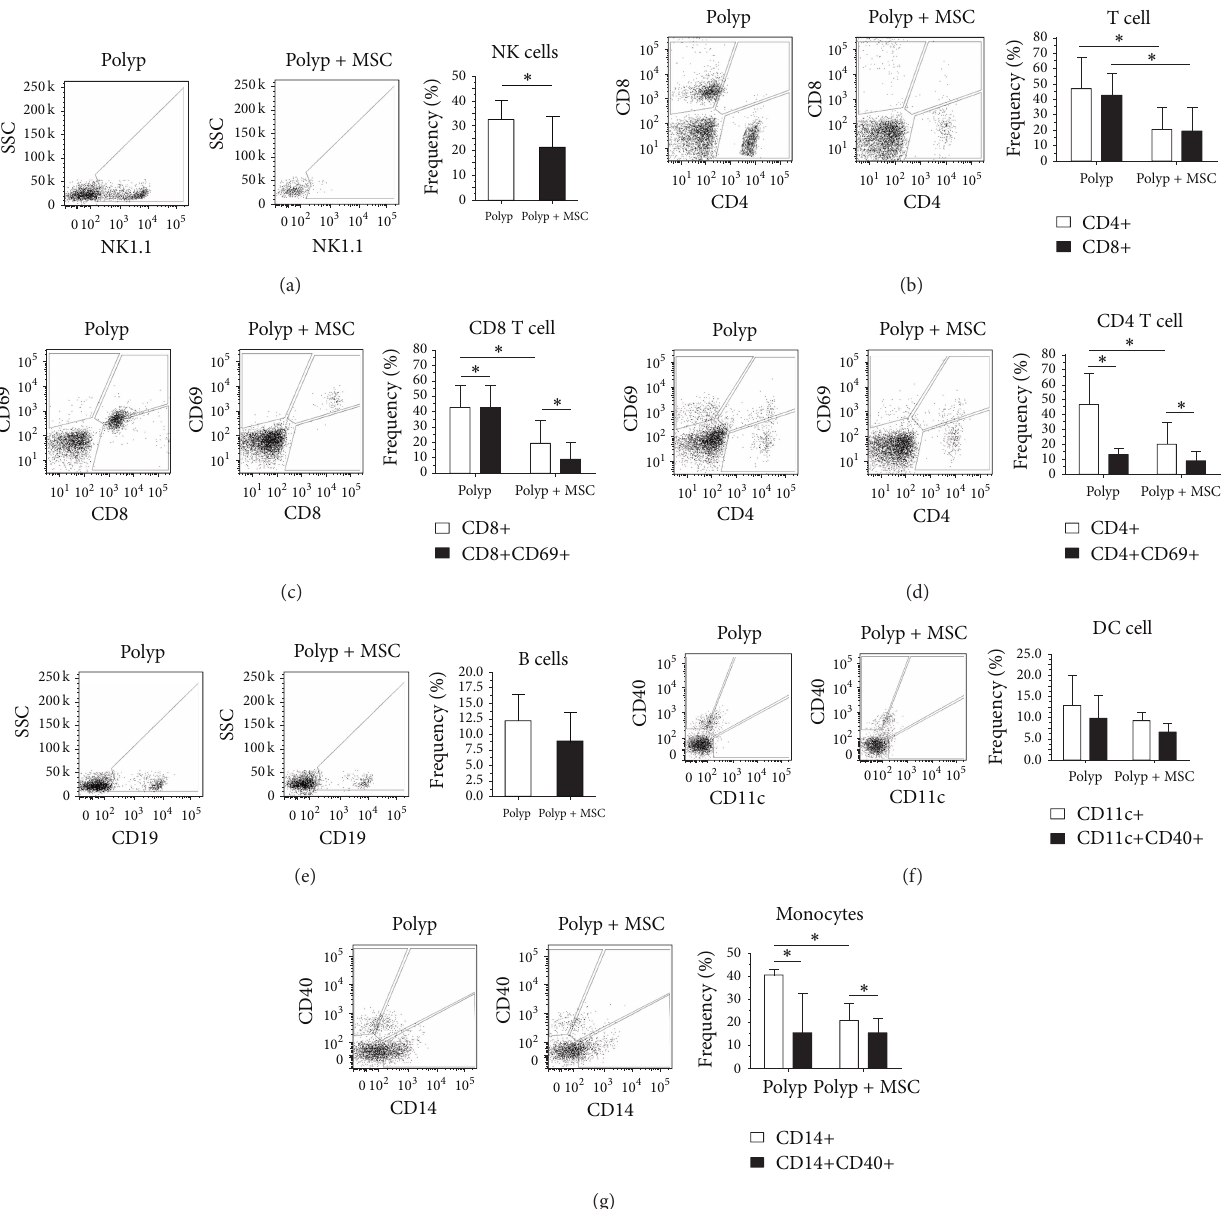
Figure 3: Bone marrow-derived mesenchymal stem cells modulating the polyp microenvironment in vitro . (a) NK cell (NK1.1+) frequency alone and in coculture with MSCs; (b) CD4+ and CD8+ frequencies alone and in coculture with MSCs; (c) CD8+ and CD69+ frequencies alone and in coculture with MSCs; (d) CD4+ and CD69+ frequencies alone and in coculture with MSCs; (e) B cell (CD19+) frequency alone and in coculture with MSCs; (f) CD11c+ and CD11c+CD40+ dendritic cell frequencies alone and in coculture with MSCs and CD14+ and CD14+CD40+ monocyte frequencies alone and in coculture with MSCs. The presence of MSCs may immunomodulate the phenotype of polyp-derived cells toward an immunosuppressive